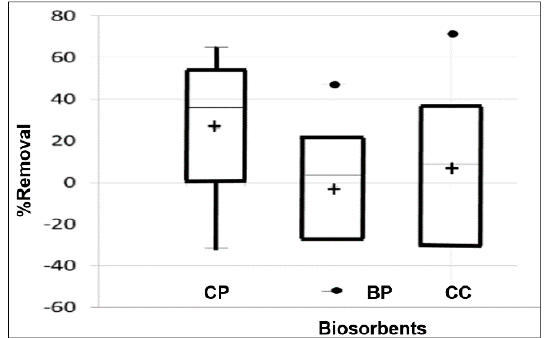
Figure 4. Box plot of the three agricultural wastes.